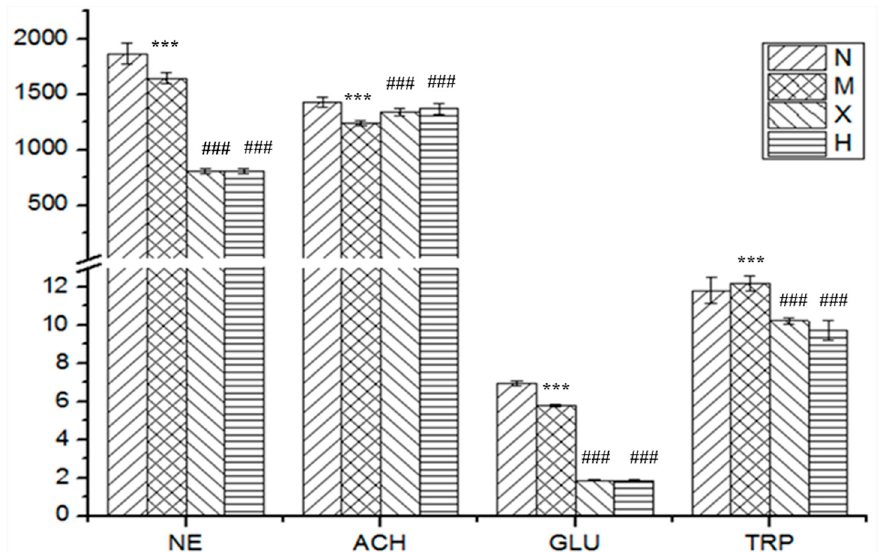
Figure 2. Mean concentration of four differential analytes ( p < 0.05, analyzed by Student’s t -test and the nonparametric Mann-Whitney test) in rat brain in different groups (N: normal group; M: model group; X: X. sorbifolia group; H: huperzine administration group).NE, norepinephrine; Ach, acetyl- choline; Trp, L -tryptophan; Glu, glutamic acid. *** p < 0.001 compared with Group N, ### p < 0.001 compared with Group M.